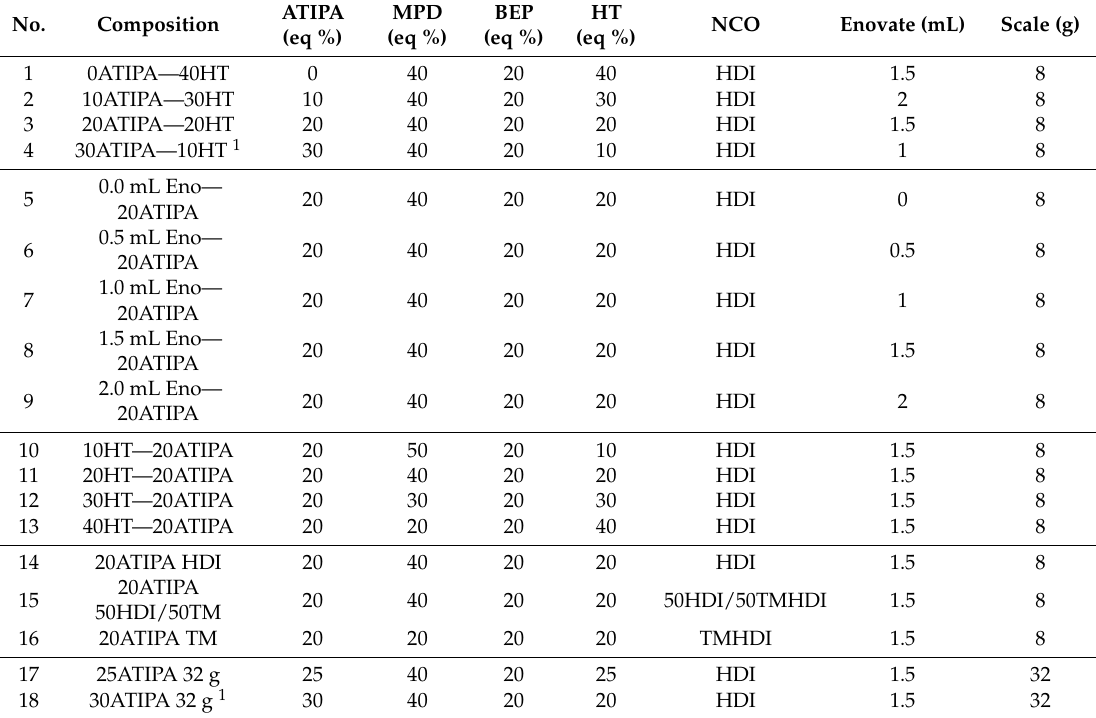
Table 1. 5-amino-2,4,6-triiodoisophthalic acid (ATIPA) foam compositions; MPD: 3-methyl-1,5- pentanediol, BEP: 2-butyl-2-ethyl propanediol, HT: 1,2,6-hexanetriol, NCO: isocyanate,